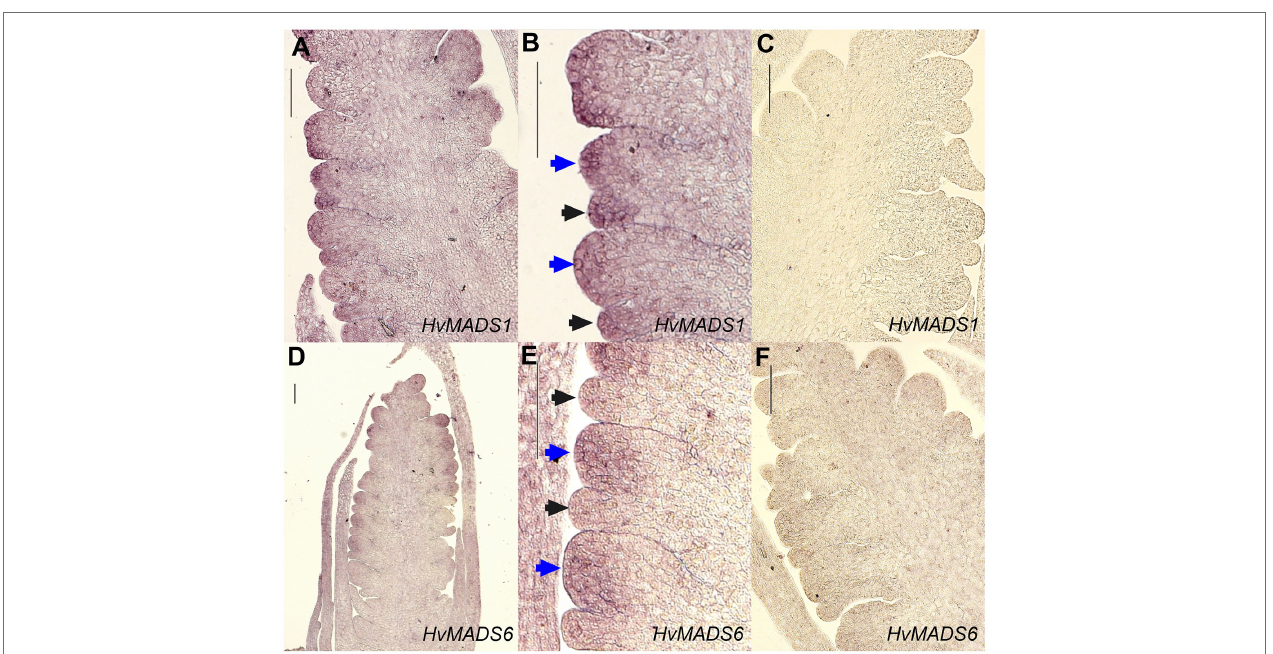
FIGURE 8 | In situ hybridisation of HvMADS1 and HvMADS6 probes to sections of the barley inflorescence at W3. HvMADS1 is expressed in the floret meristem (blue arrowheads) and the lemma primordium (black arrowheads; A,B ), but HvMADS6 is more strongly expressed in the floret meristem (D,E) . (C, F) are the sense probe controls. Scale bars: 100 μ